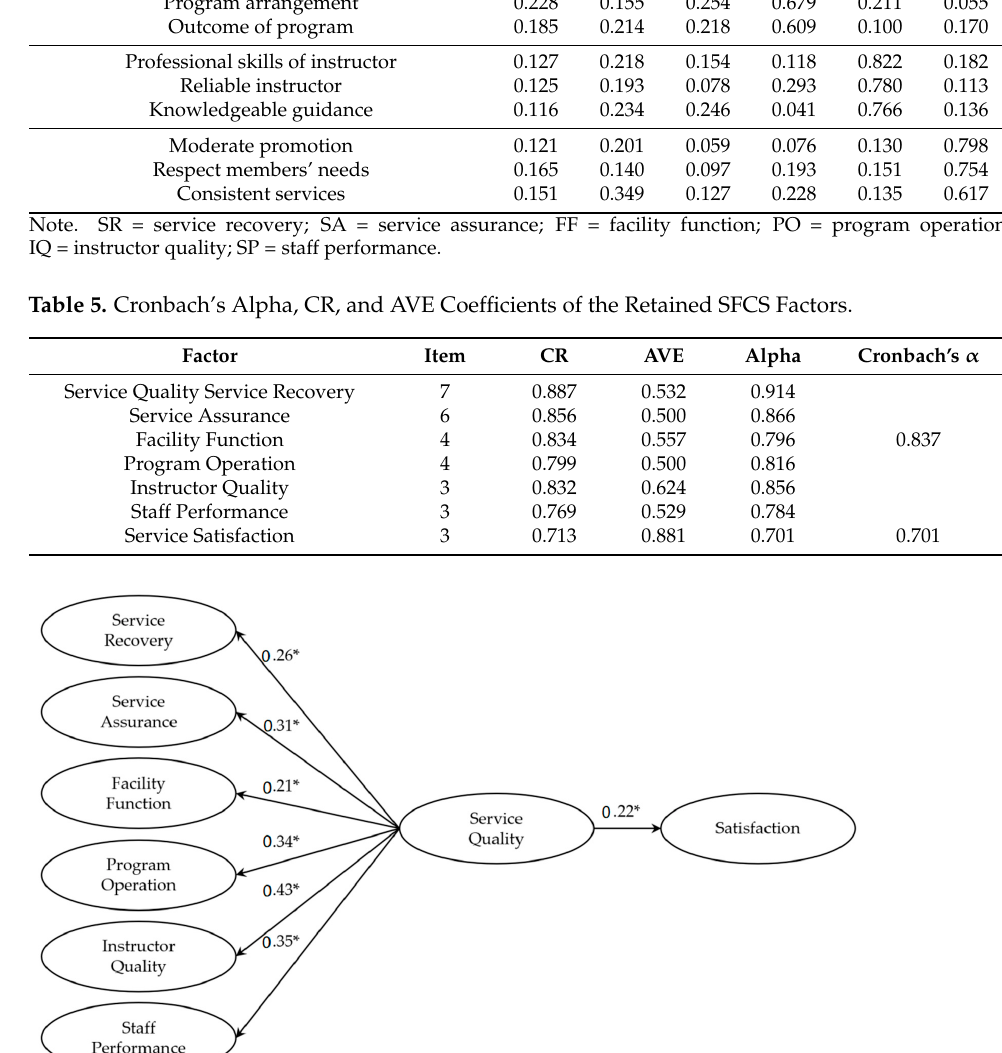
Table 5. Cronbach’s Alpha, CR, and AVE Coefficients of the Retained SFCS Factors.